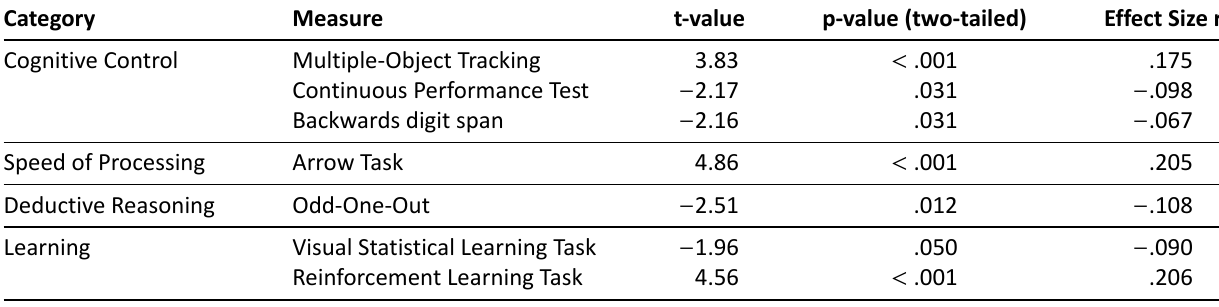
Figure 1. Values from general linear model between League of Legends MMR and cognitive abilities. Table A3. Regression values between League of Legends MMR and